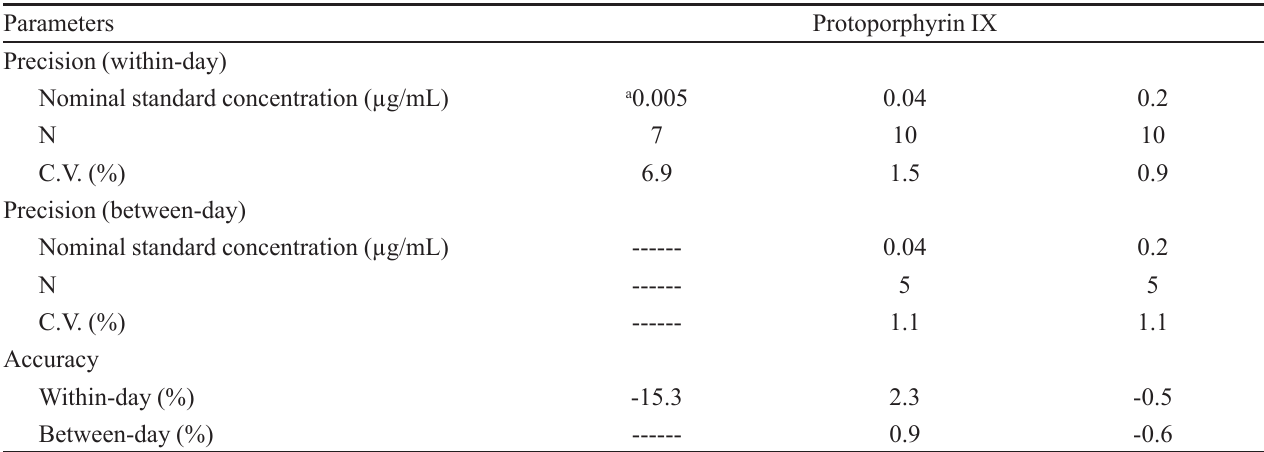
TABLE I - Analysis of the precision and accuracy of the fluorometric method for PpIX assay in DMSO